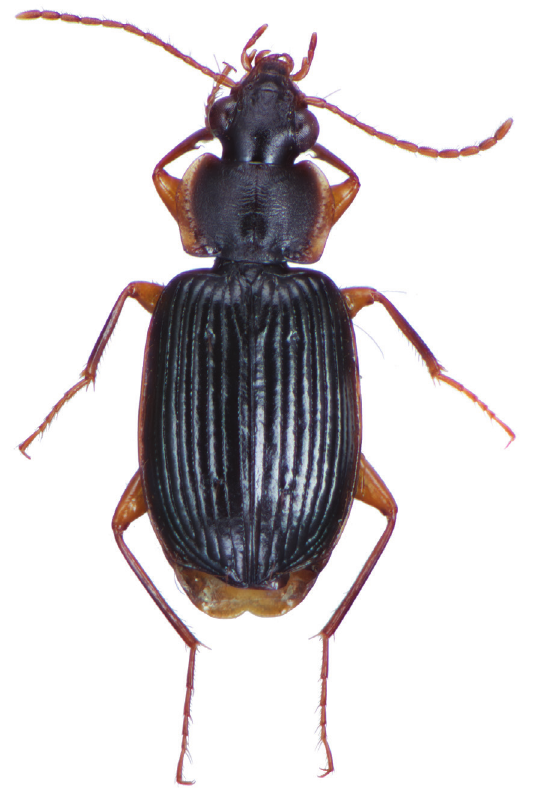
Figure 4. Dorsal habitus and color pattern of Amphimenes absensacidus sp. n.. (OBL 6.40 mm).